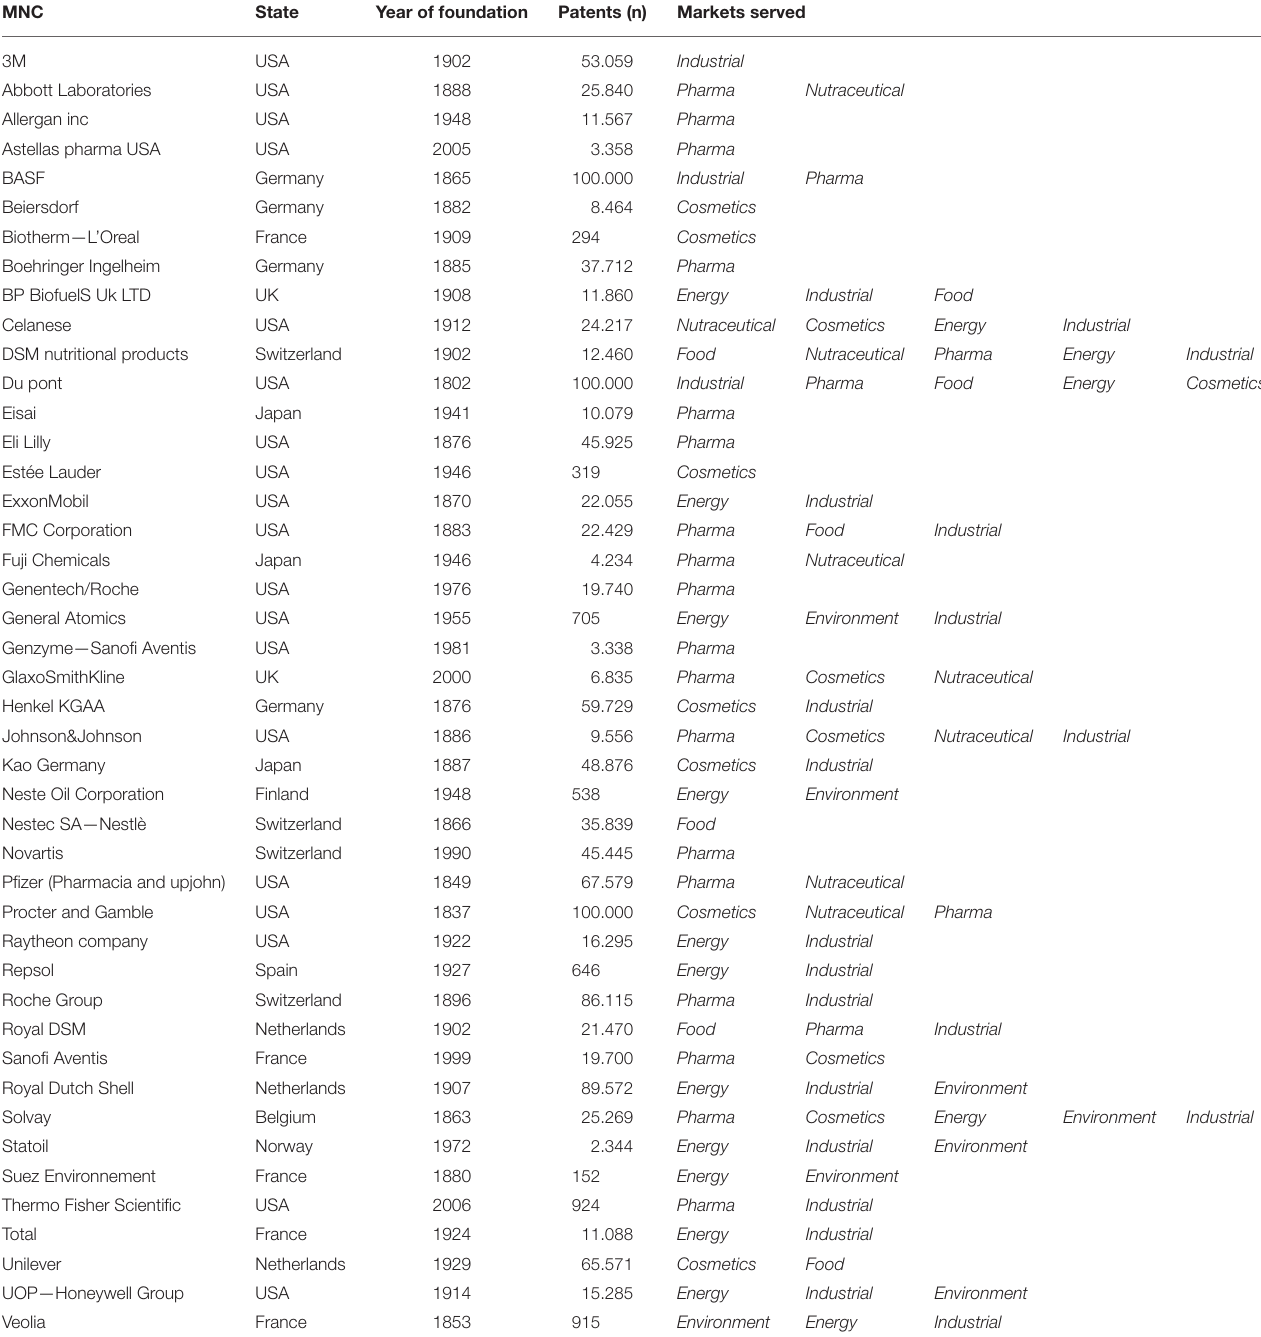
TABLE 2 | The Multi-National Corporations of the